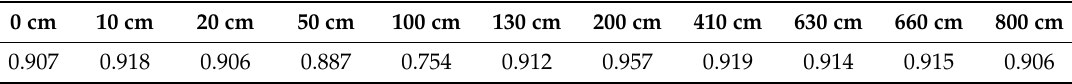
Figure 6. Spatial and temporal variations of the soil unfrozen water contents during the months of ( a ) November 2017, ( b ) December 2017, ( c ) January 2018, ( d ) February 2018, and ( e ) March 2018. Table 4. Correlation coefficients between soil temperatures and unfrozen water contents at various depths. All values pass the test at a 0.01 significance level.